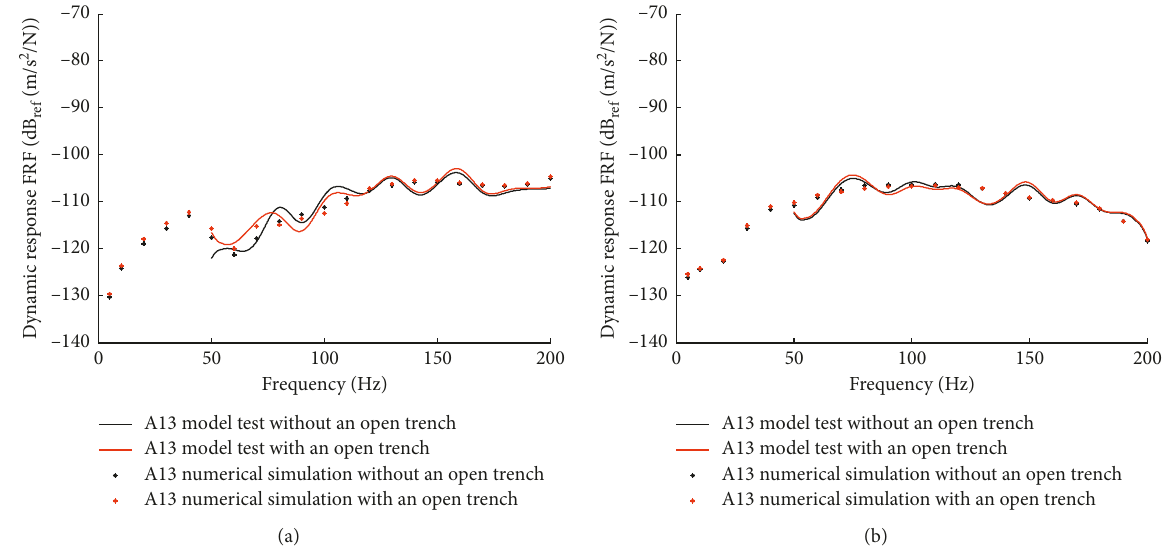
Figure 9: Vertical dynamic response of surface measuring points in front of the open trench. (a) Testing point A13. (b) Testing point